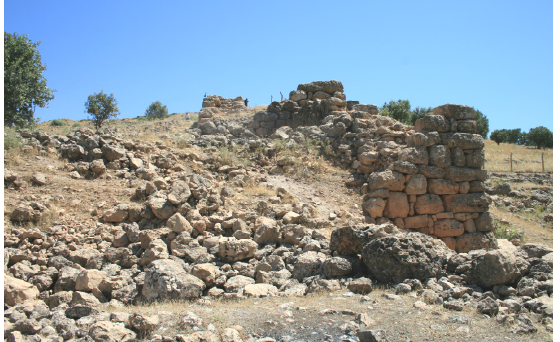
Fig. 9. The Roman-Byzantine curtain wall of Be ş ikkaya, view from SW to NE. Photo: Kenneth Silver 2016.